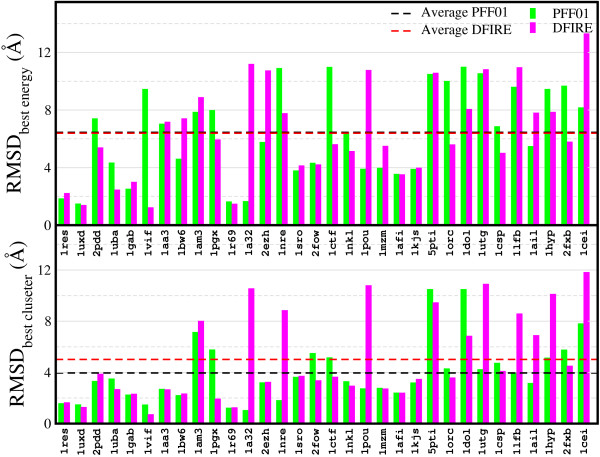
Comparison with DFIRE: RMSD of best energy (top row) and best cluster (bottom row) for the decoy sets by PFF01 (green bar) with DFIRE (red bar). The dashed lines indicate the averages over all decoy sets.